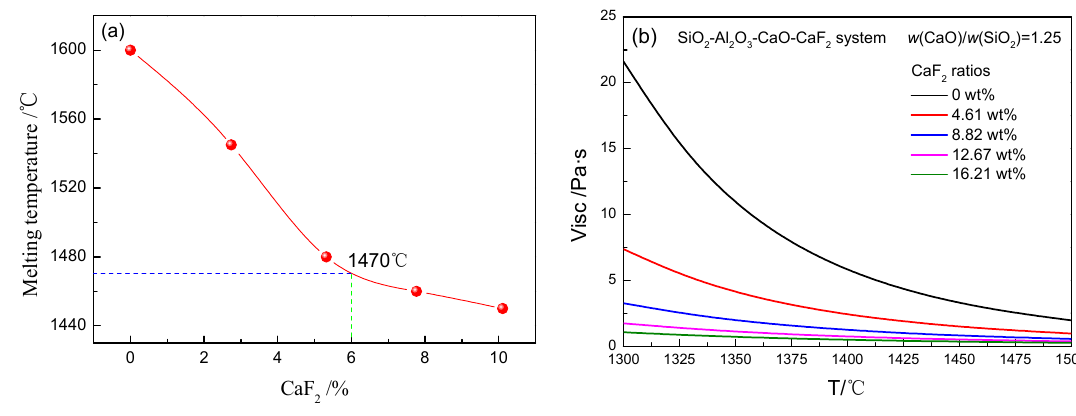
Figure 11. Effect of ( a ) temperature and ( b ) CaF 2 content on the slag viscosity.